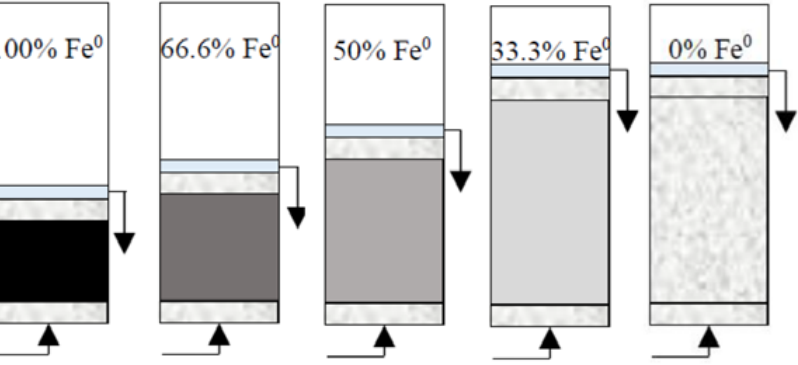
Figure 2. Experimental setup for column tests with reactive zone having fixed Fe 0 volume (20 cm 3 ) and variable total volume V 2 (20, 30, 40 and 60 cm 3 ). The control (0% Fe 0 ) column is also depicted.